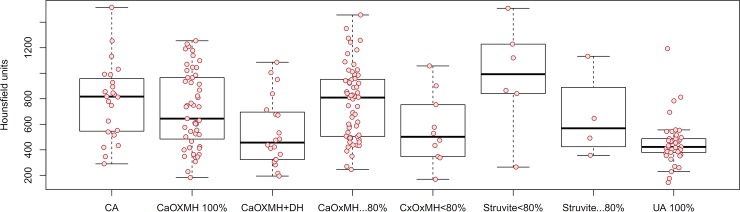
Mean stone density in noncontrast computed tomography values according to stone composition.CA: carbonate apatite; CaOx: calcium oxalate; MH: monohydrate; DH: dehydrate; UA: uric acid.